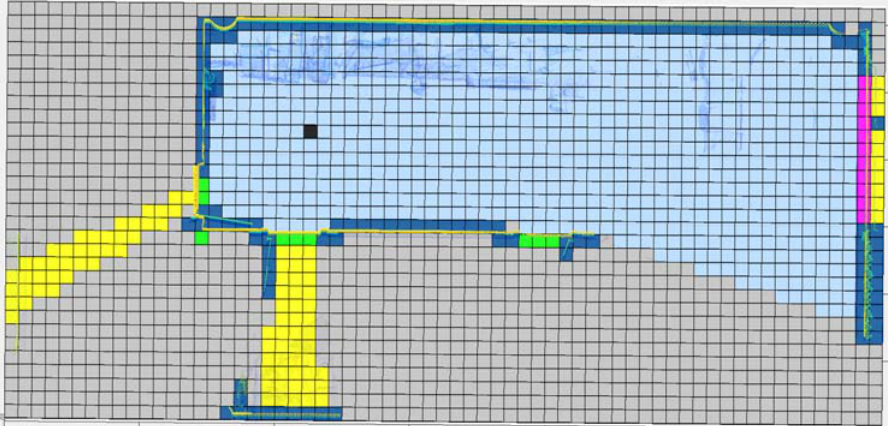
Figure 13. Discretized room. Voxel plane 1.5 m high. Dark blue: occupied; light blue: empty; green: door; magenta: window; grey: occluded; yellow: out; black: scanner position.